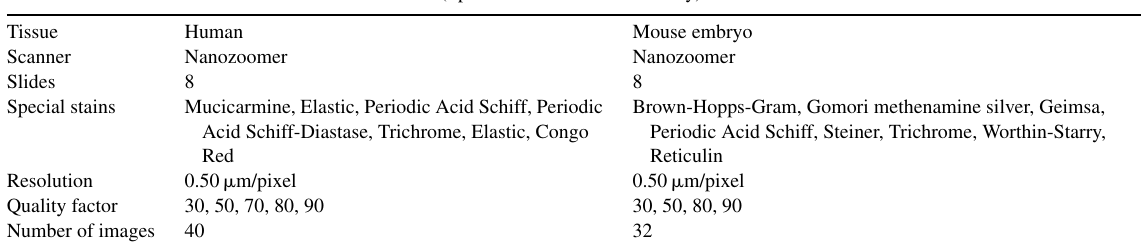
(Special stains used in the